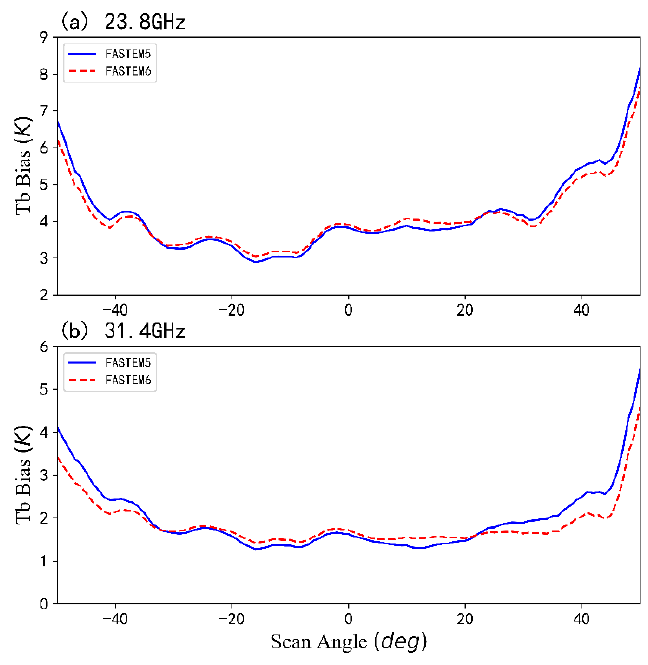
Figure 2. Mean biases (O − B, unit: K) of simulated brightness temperatures from observed tempera- tures versus scan angle (Abscissa, unit: degree) under clear atmosphere over oceans at ( a ) 23.8 GHz and ( b ) 31.4 GHz.